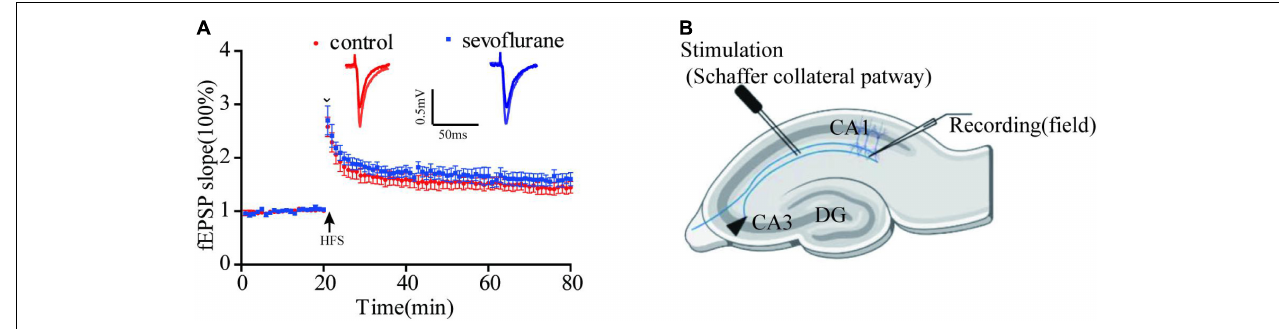
FIGURE 5 | Sevoflurane did not significantly change long-term potentiation (LTP). (A) We tested 0, 20, 40, and 60 min after high-frequency stimulation, and the response of sevoflurane exposure group to HFS has a mild increase than that of control group, but it was not statistically significant. (B) The position of stimulating and recording electrode in CA1 region. Data are presented as mean ± SEM ( n = 6 slices from 5 mice for control group and n = 5 slices from 5 mice for sevoflurane group).